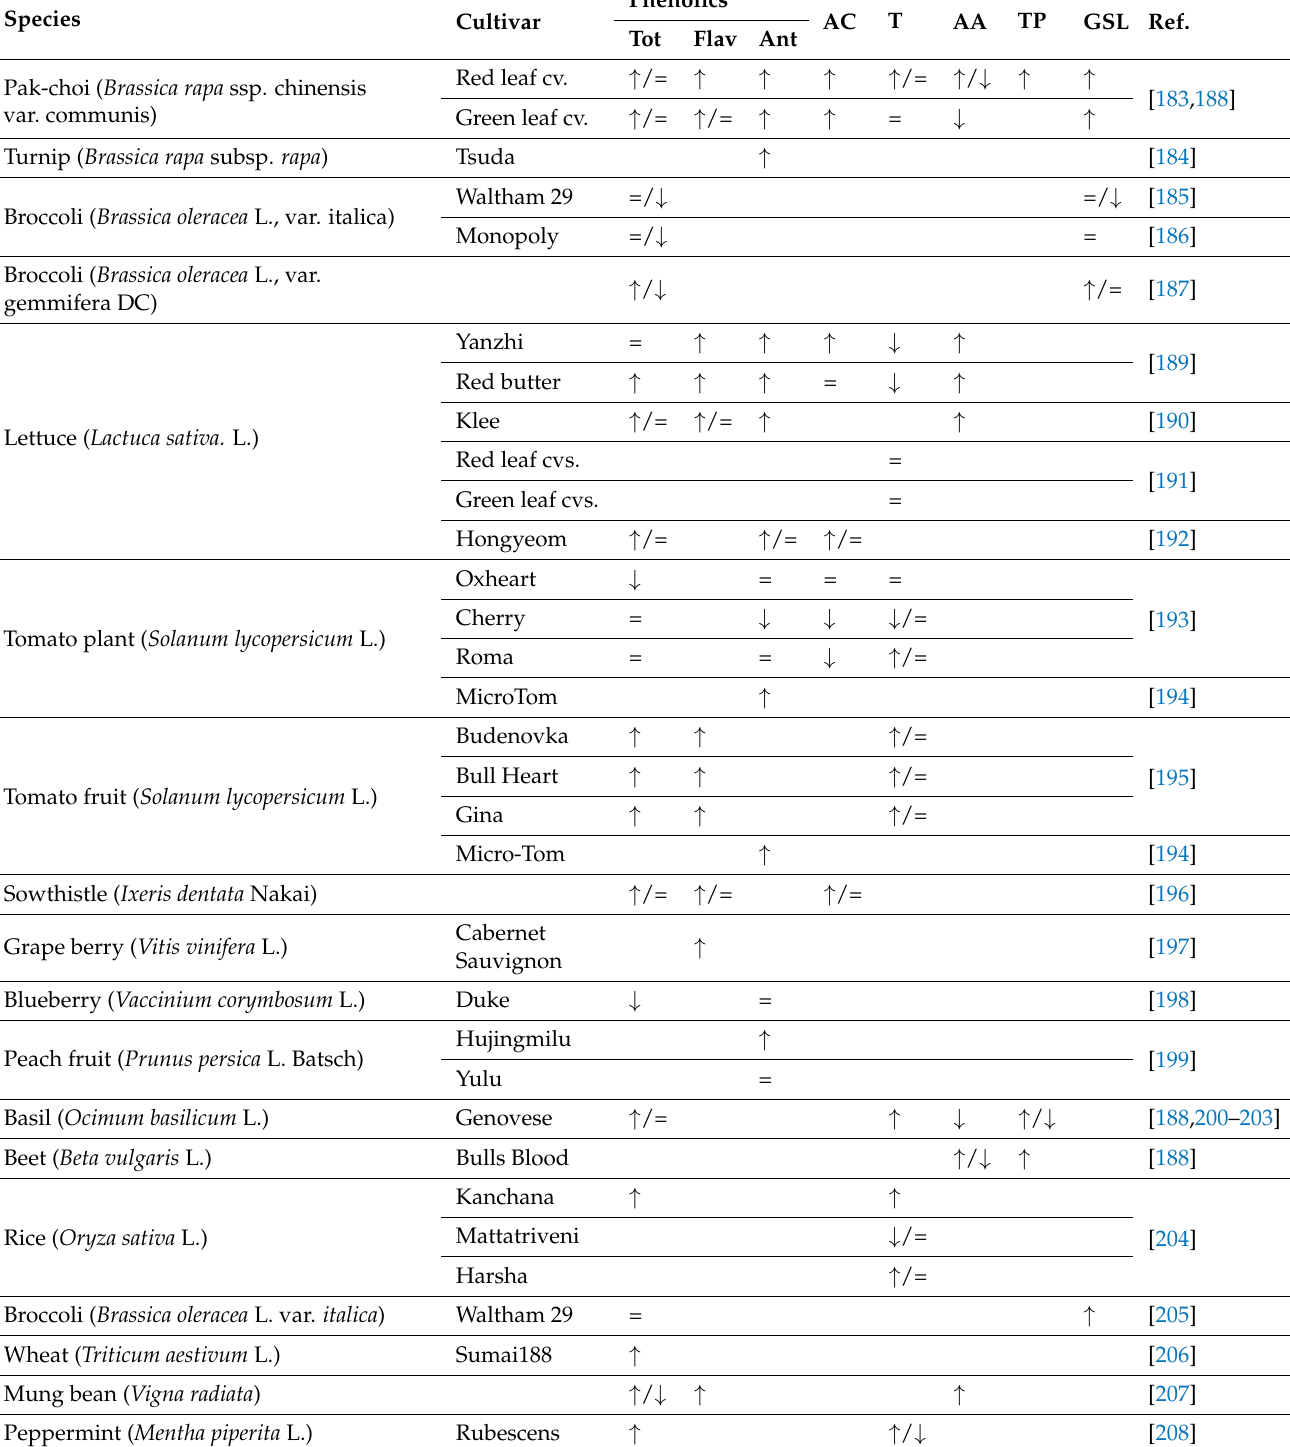
Table 4. Biochemical responses of crops and plants of food interest to UV-A wavelengths considered in this review. Tot, total phenolics; Flav, flavonoids; Ant, anthocyanins; AC, antioxidant capacity; T, terpenoids; AA, ascorbic acid; TP, tocopherols; GSL, glucosinolates. For each plant species and cultivar, and for each secondary metabolite or metabolic class considered, the symbols “ ↓ ”, “ ↑ ” and “=” mean a decrease, increase or no variations, respectively, compared to the control plants of each